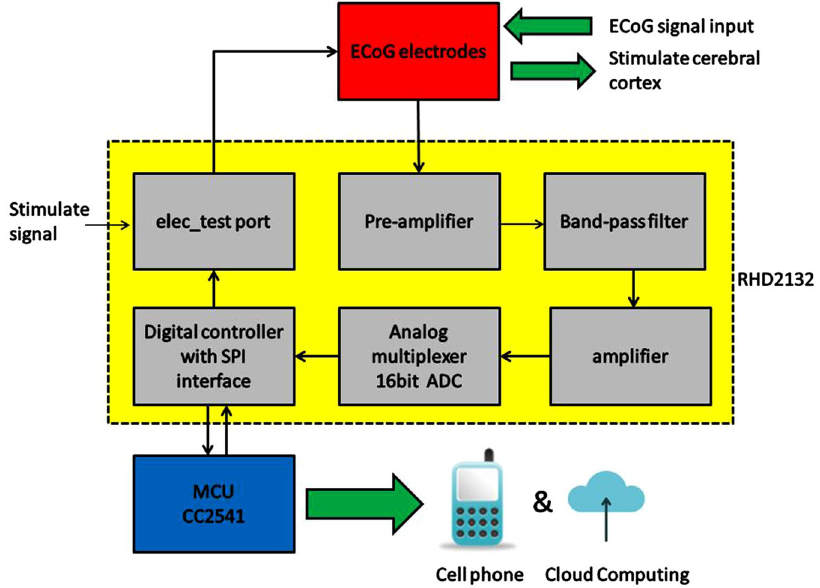
Figure 1. Diagram of the ECoG system. The red block is the ECoG electrode device with an array of 32 flexible microelectrodes, which are used to record ECoG signals of a brain or apply stimulation electrical signal to suppress epilepsy; the yellow block is the electronic circuits which acquire and process ECoG signals; the blue block is the microcontroller unit controlling the ECoG system, and communicate with cell phone ad cloud system for data processing